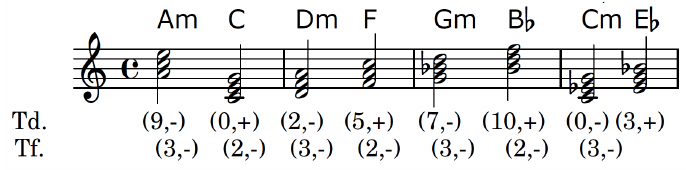
Figure 8. Another output example, UTT-based method.